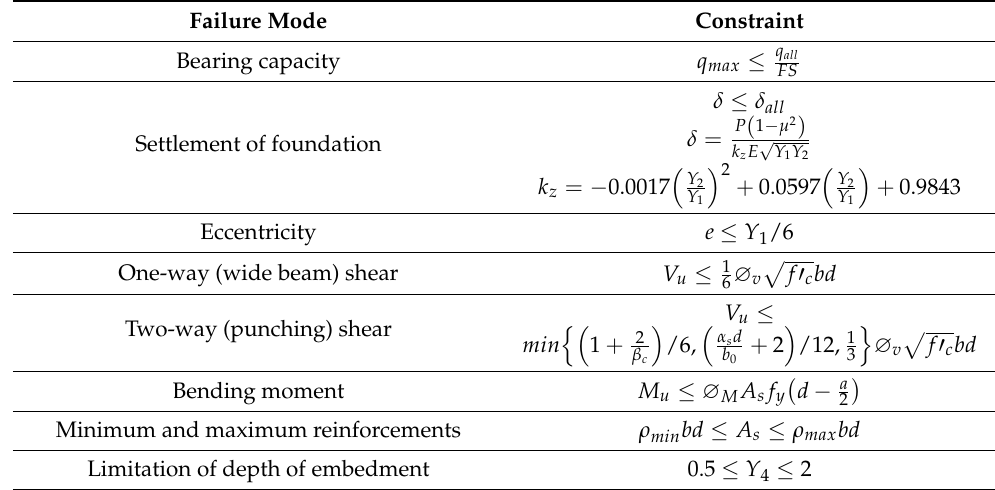
Table 9. Definition of parameters of Table